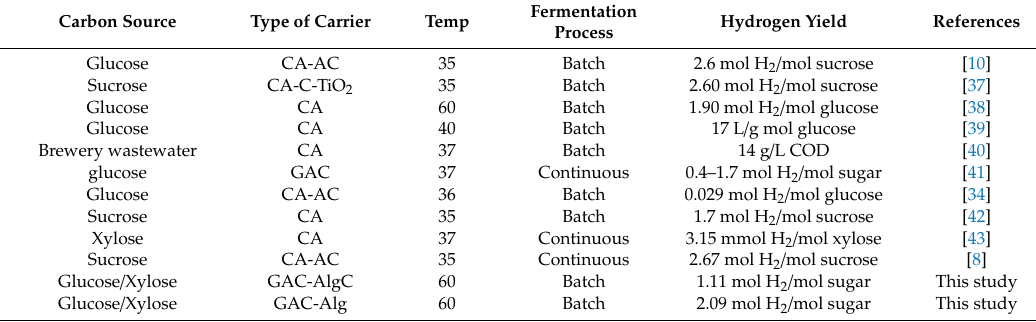
Figure 7. ( a ) Cell-immobilised GAC; ( b ) cell-immobilised GAC–Alg; ( c ) cell-immobilised GAC–AlgC. Table 5. Comparative study on the e ffi ciency of di ff erent types of immobilisation beads on hydrogen